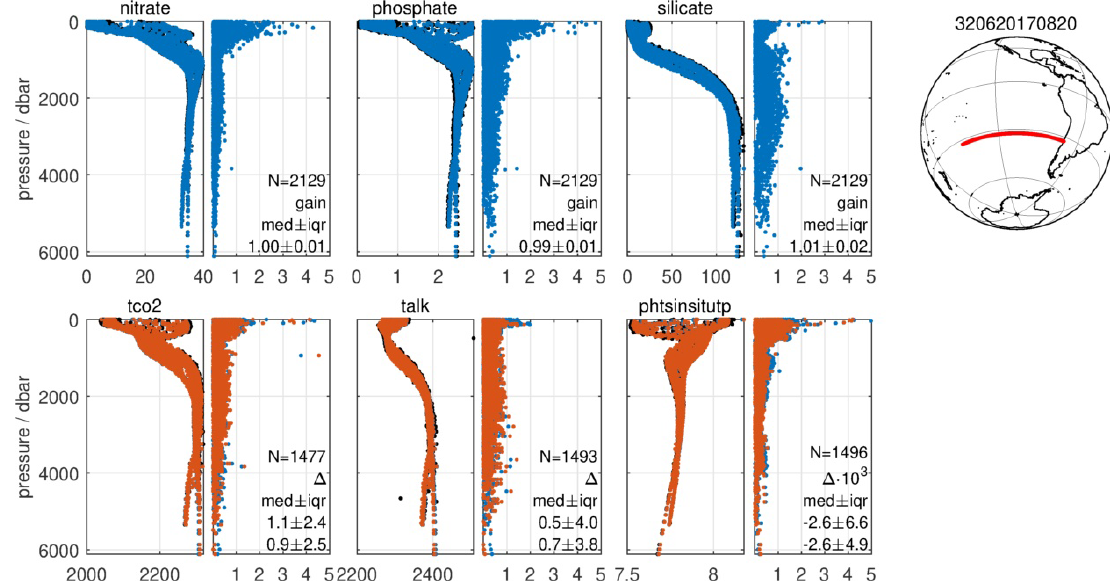
Figure 5. Example summary figure for CANYON-B and CONTENT analyses for 320620170820. Any data from regions where CONTENT and CANYON-B were not trained are excluded. The top row shows the nutrients and the bottom row the seawater CO 2 chemistry variables. All are shown versus sampling pressure (dbar) and the unit is micromoles per kilogram (µmolkg − 1 ) for all except pH, which is on the total scale at in situ temperature and pressure. Black dots (which to a large extent are hidden by the predicted estimates) are the measured data, blue dots are CANYON-B estimates, and red dots are the CONTENT estimates. Each variable has two figure panels. The left shows the depth profile, while the right shows the absolute difference between measured and estimated values divided by the CANYON-B and CONTENT uncertainty estimate, which is determined for each estimated value. These values are used to gauge the comparability; a value below 1 indicates a good match as it means that the difference between measured and estimated values is less than the uncertainty of the latter. The statistics in each panel are for all data deeper than 500dbar, and N is the number of samples considered. A multiplicative adjustment and its interquartile range are given for the nutrients. For the seawater CO 2 chemistry variables the numbers in each panel are the median difference between measured and predicted values for CANYON-B (upper) and CONTENT (lower). Both are given with their interquartile